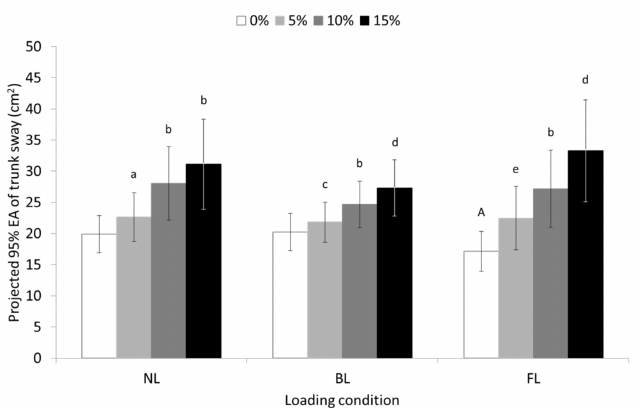
Figure 6. Means and 95% confidence intervals (error bars) for the projected trunk sway’s 95% ellipse area during unloaded (UL), back-loaded (BL), and front-loaded (FL) walking at 0 (level), 5, 10, and 15% uphill slope. a significant different (SD) compared to 0% slope ( p ≤ 0.01); b SD compared to 0 and 5% slope ( p ≤ 0.001); c SD compared to 0% slope ( p ≤ 0.05); d SD compared to 0 ( p ≤ 0.001) and 5% slope ( p ≤ 0.01); e SD compared to 0% ( p ≤ 0.001); A SD compared to UL ( p ≤ 0.05) and marginally SD compared to BL condition ( p = 0.054).